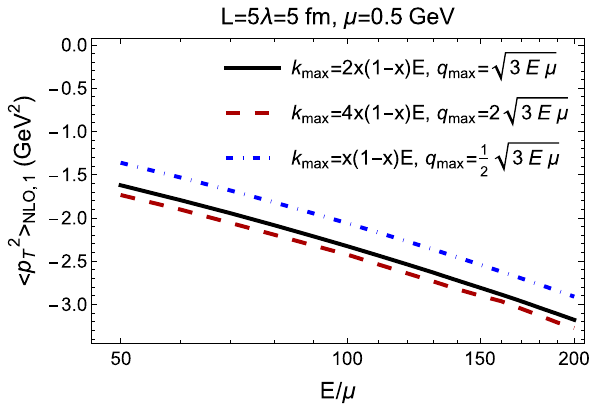
Fig. 10 DGLV radiative broadening contribution at first order in opac- ity for different choices of the kinematic limits of